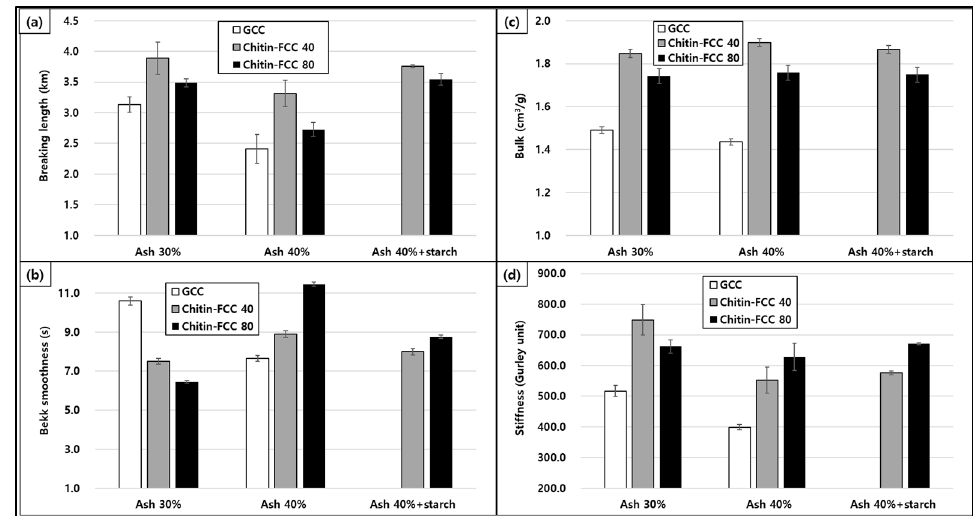
Figure 8. Paper properties including breaking length ( a ), smoothness ( b ), bulk ( c ), and stiffness ( d ) of the papers containing GCC, chitin-FCC, and chitin-FCC with starch.